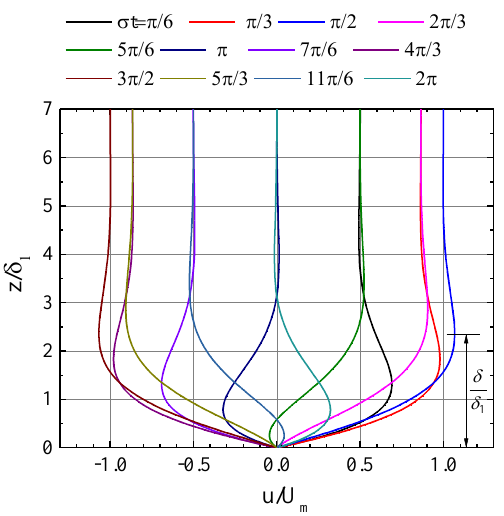
Figure 1. Velocity distribution in laminar wave boundary layer.